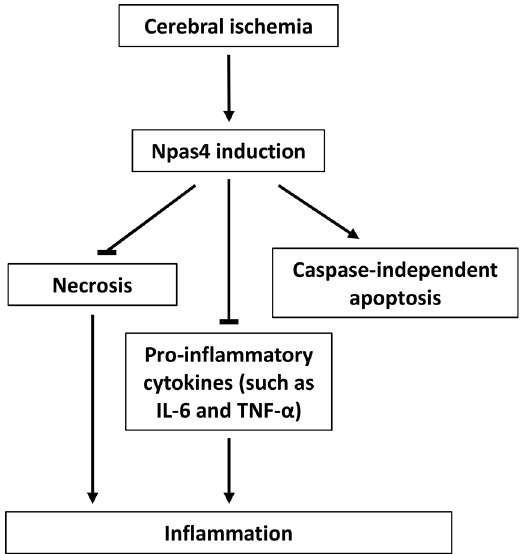
Figure 2. Model of Npas4 neuroprotective function following cerebral ischemia. Ischemic challenge induces Npas4 expression, which then limits brain damage via two mechanisms: (1) by modulating the cell death pathway such that damaged cells undergo apoptosis in preference to necrosis and (2) by suppressing inflammation.